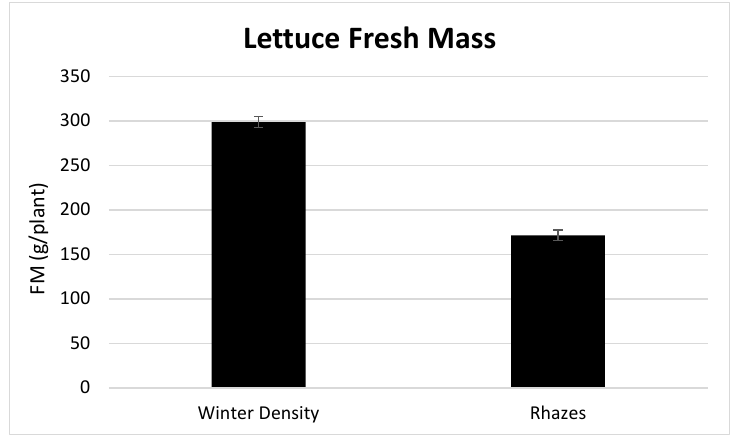
Figure 4. The interaction of growing season and electrical conductivity (EC) treatment on lettuce leaf fresh mass. The standard error of the mean: 12.65. The EC treatment: high = 4.0 mS · cm −1 , medium = 2.0 mS · cm −1 , and low = 1.0 mS · cm −1 .